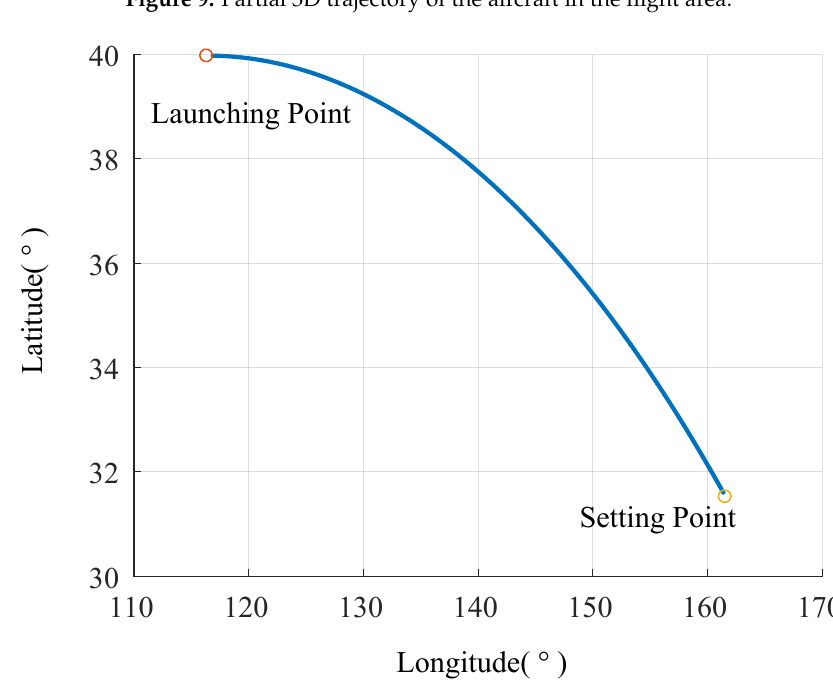
Figure 10. Trajectory of the aircraft under latitude and longitude